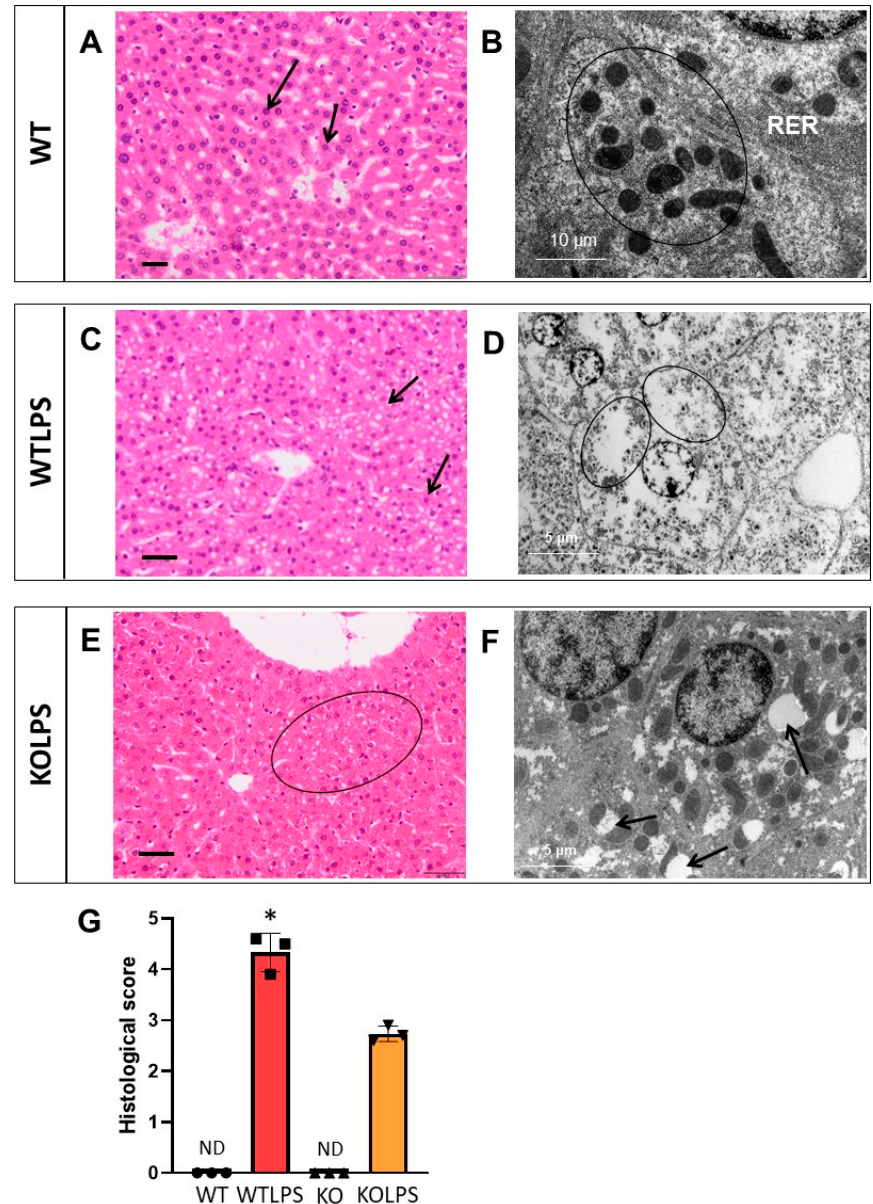
Figure 10. Histopathology of the livers of mice from the different treatments assayed. ( A ) Hepatic lobule with Remak cords of apparently normal hepatocytes (arrow). ( B ) Detail of hepatocyte with abundant rough endoplasmic reticulum (RER) and mitochondria (circle). ( C ) Hepatic parenchyma, appreciating abundant unilocular and multilocular steatosis (arrow). ( D ) Detail of hepatocyte with abundant diffuse fat (circle). ( E ) Detail of Remak cords with steatosis in the hepatocytes (circle). ( F ) Hepatocytes with vacuolations of its membranous system (arrow). ( G ) Histological score showing a semiquantitative analysis of steatosis in the liver. The pathology scores were as follows: 0, without significant injuries (0%); 1, minimum (<10%); 2, mild (11–25%); 3, moderate (26–50%); 4, marked (51–75%); 5, severe (>75%). Histopathological evaluation is performed in a blind manner by two highly experienced pathologists. Results are mean ± SD of N = 3 animals.Statistical significance (two tailed Student- t test): * p < 0.001. Abbreviations: WT, wild type mice; WTLPS, wild type mice treated with LPS; KO, Gal3 knockout mice; KOLPS, Gal3 knockout mice treated with LPS; ND, not damaged. ( A , C , E ), optical microscopy. Scale bars: 100 µ m. ( B , D , F ), ultrastructural observations. Scale bars: ( B ), 10 µ m; ( D , F ), 5 µ